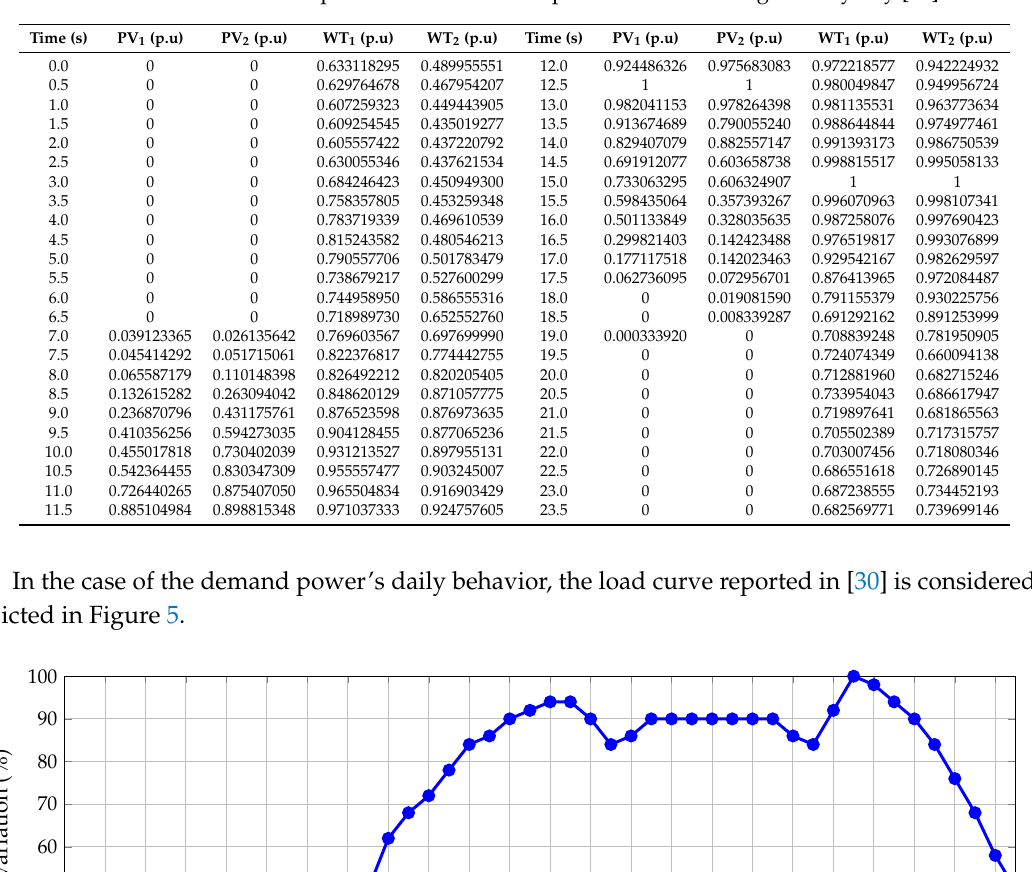
Table 4. Behavior of the photovoltaic and wind power sources during a sunny day [28].